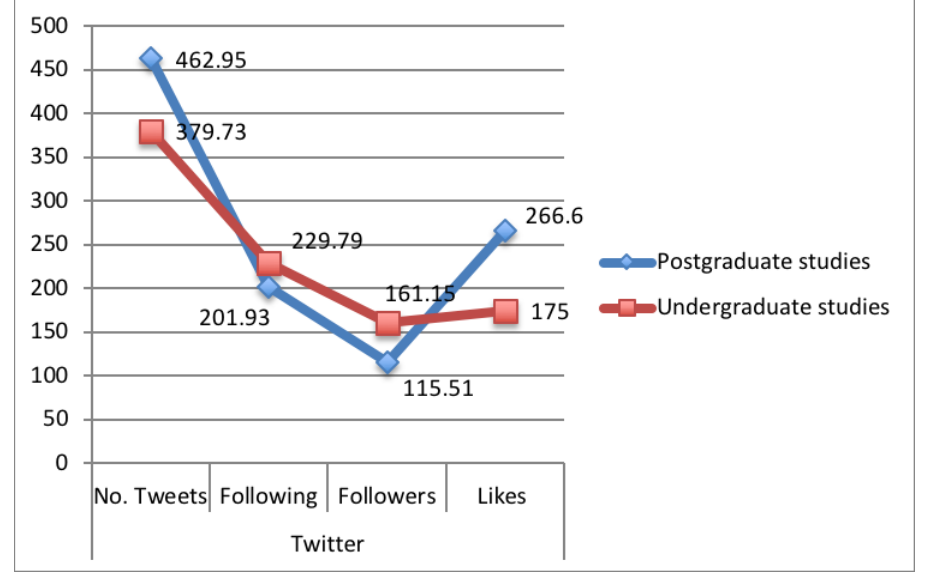
Figure 1 . Descriptive analysis of Twitter participation